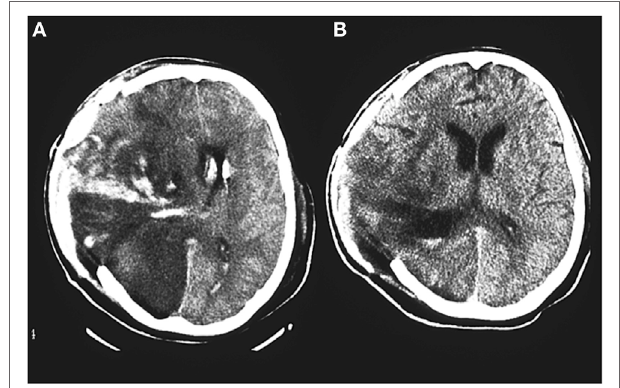
FiGURe 6 | A CT scan of the brain from a 65-year-old woman treated with the Lund concept after a severe traumatic brain injury and craniectomy. (A) A CT scan before start of prostacyclin infusion. (B) A CT scan after 4 days of prostacyclin infusion (1 ng/kg/min i.v.). There are signs of improved perfusion of an area with compromised perfusion on the right side of the